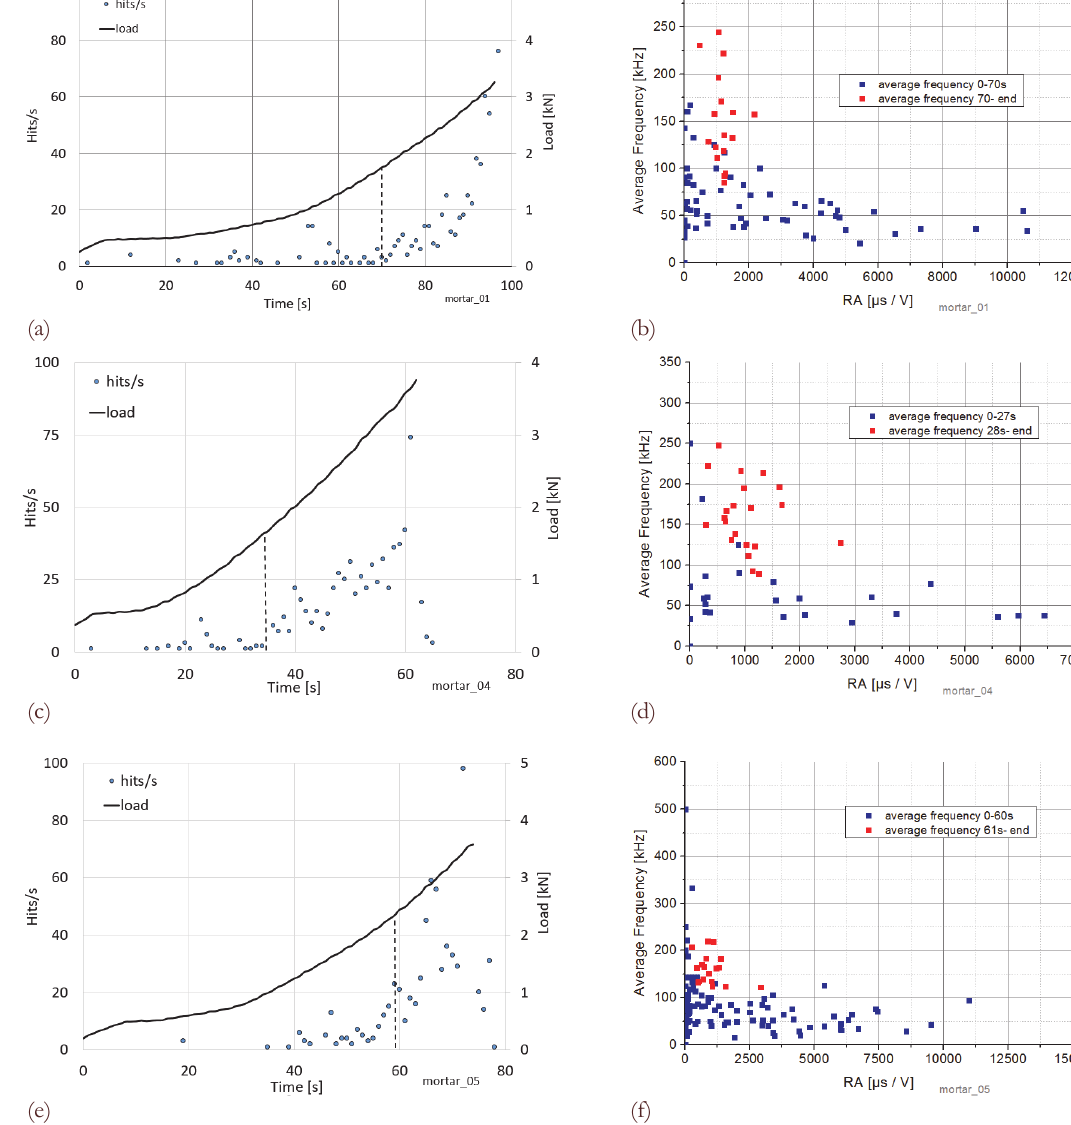
Figure 10: (a), (c), (e) Time variation of the hits/s and the load applied for three characteristic mortar specimens under 3-point bend-ing and (b), (d), (f) the respective average frequency versus the RA